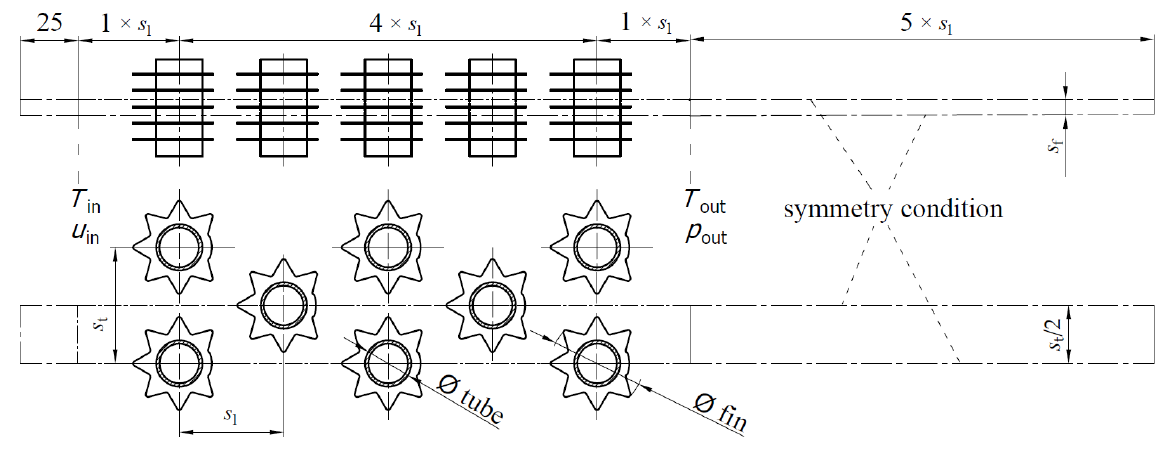
Figure 2. Computational domain.